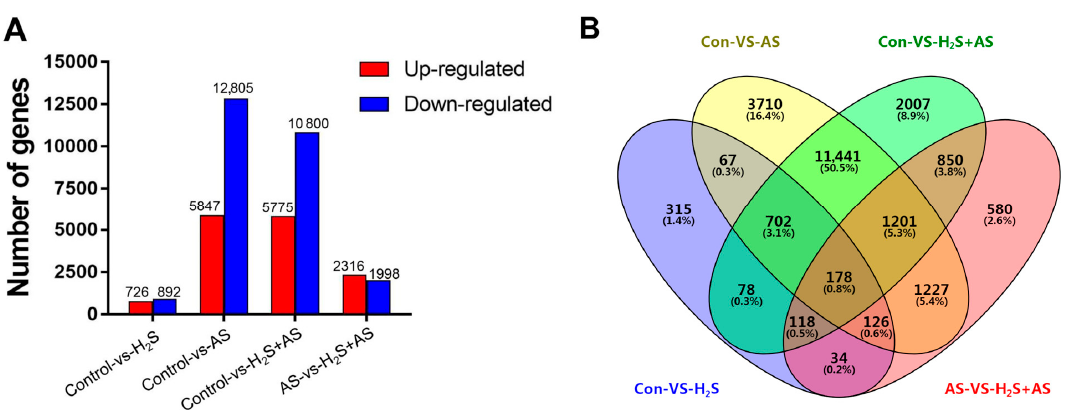
Figure 2. The differentially expressed genes (DEGs) of M. hupehensis after treatment with H 2 S and alkaline salt stress. The number of up- and downregulated DEGs between different comparison groups ( A ). Venn of the number of DEGs in different comparison groups ( B ).